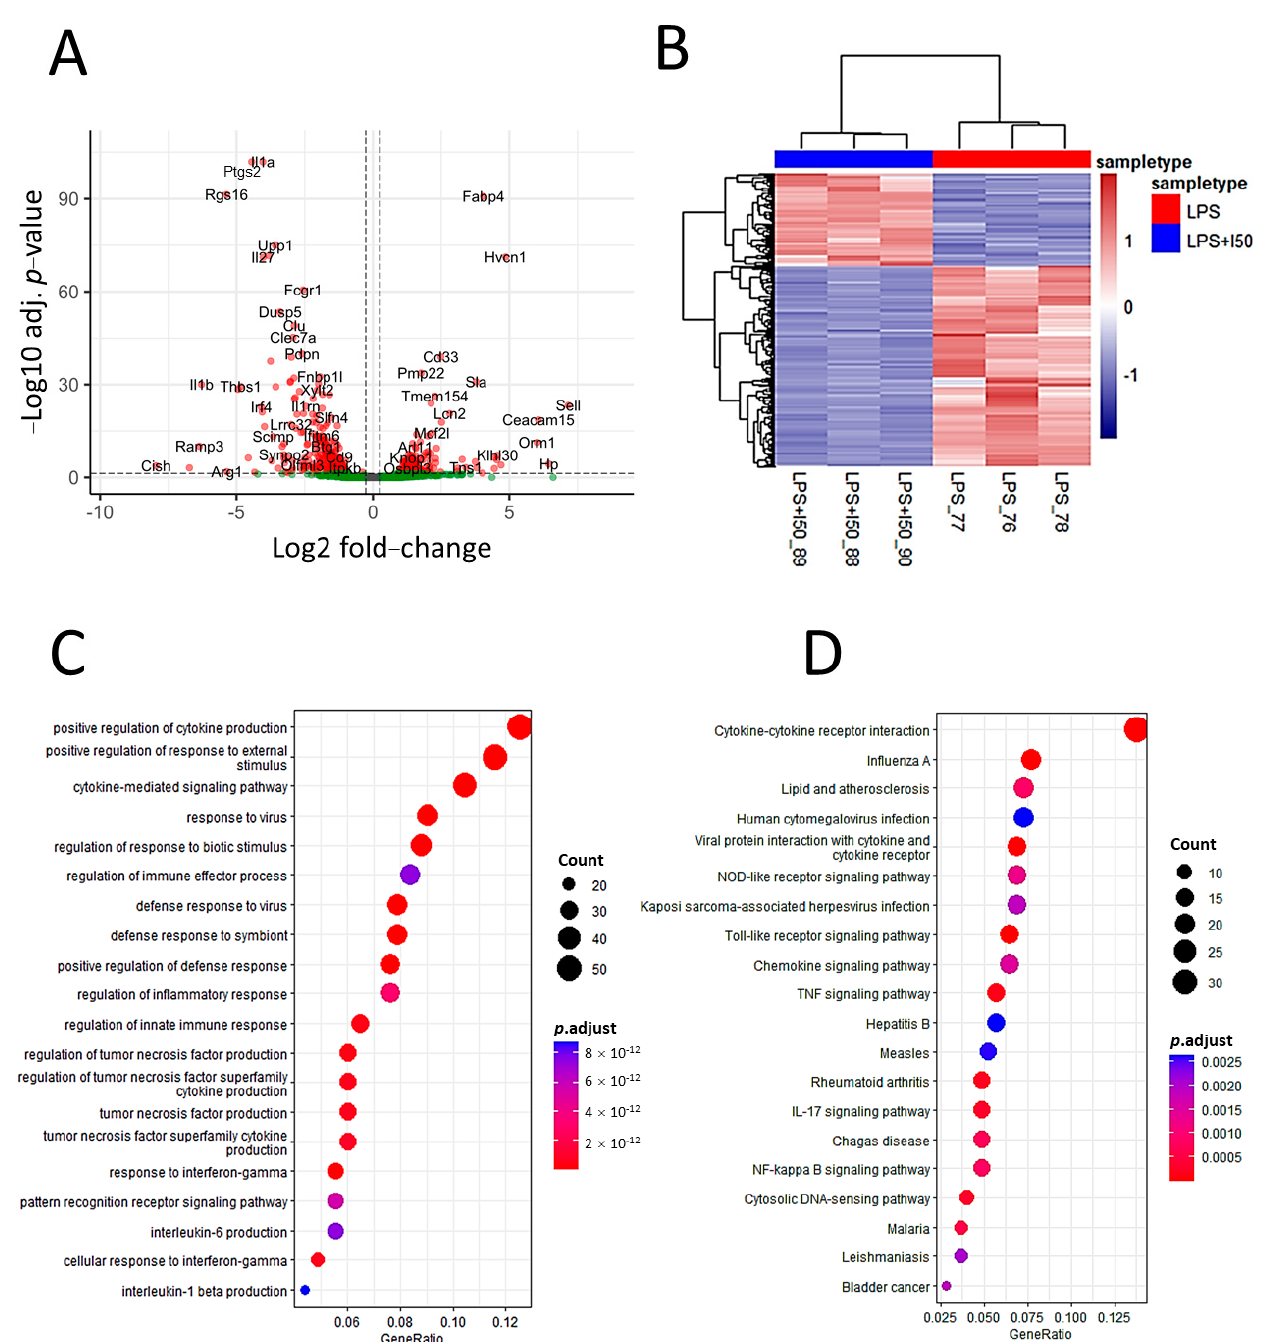
Figure 2. Transcriptomic analysis of inulin-treated, LPS-stimulated cells. ( A ) Volcano plot show- ing the relative abundances of transcripts. Transcripts with an FC value > 1.2 and an adjusted p -value < 0.05 were considered to be differentially expressed between the inulin treatment group and the LPS-stimulated group. ( B ) Hierarchical heatmap showing the expression patterns of LPS- stimulated cells treated with and without inulin using the differentially expressed genes. Samples are displayed in columns, and genes are presented in rows. ( C ) GO enrichment analysis showing top 20 enriched GO biological process terms. ( D ) Pathway enrichment analysis showing the top 20 enriched KEGG